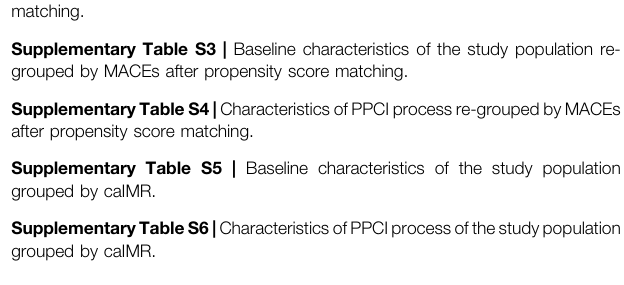
Supplementary Table S1 | Baseline characteristics of the study population after propensity score matching. Supplementary Table S2 | Characteristics of PPCI process after propensity score matching. Supplementary Table S3 | Baseline characteristics of the study population re- grouped by MACEs after propensity score matching.